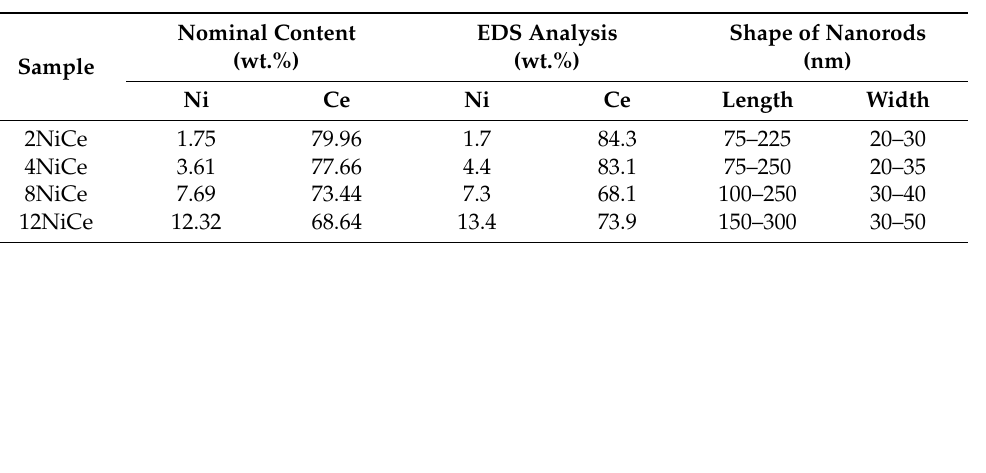
Table 1. Chemical composition and shape of nanorods of samples by field emission scanning electron microscopy/energy dispersive spectroscopy (FE-SEM/EDS)